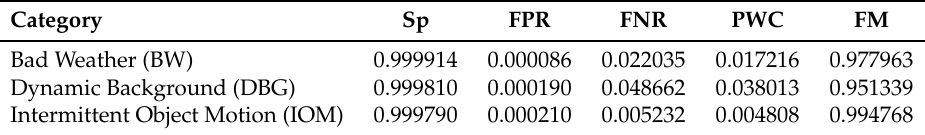
Table 4. Metrics scores of our proposed solution on each CD2014 selected category.